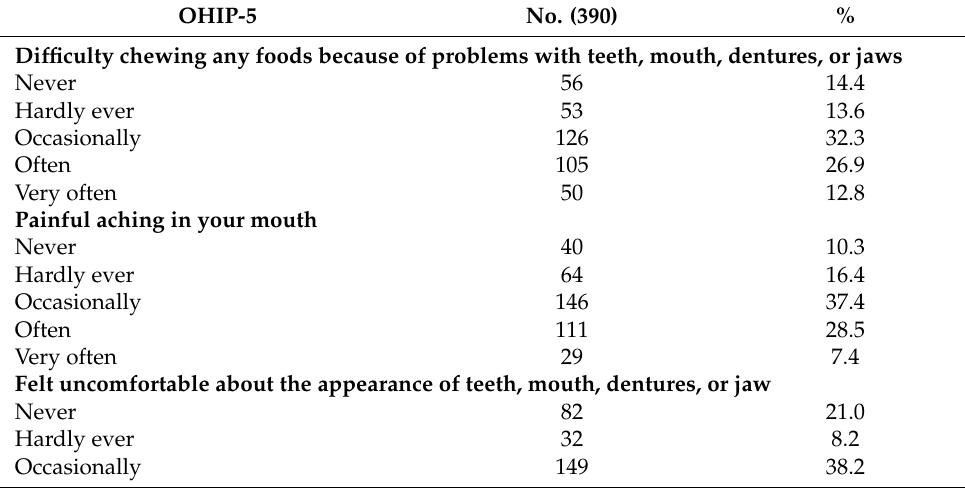
Table 3. Oral Health Impact Profile -5 (OHIP-5) scale scores of the studied older